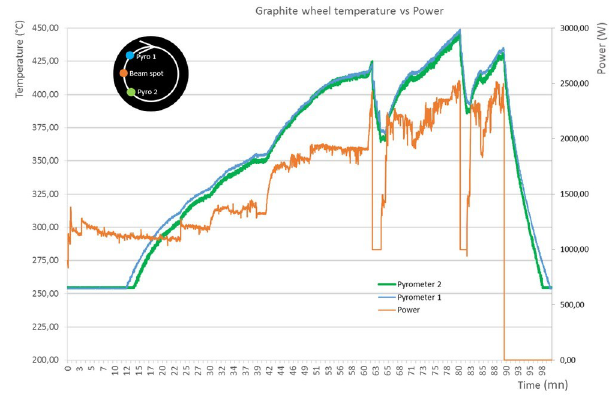
Fig. 9. Target thermal behaviour according to beam